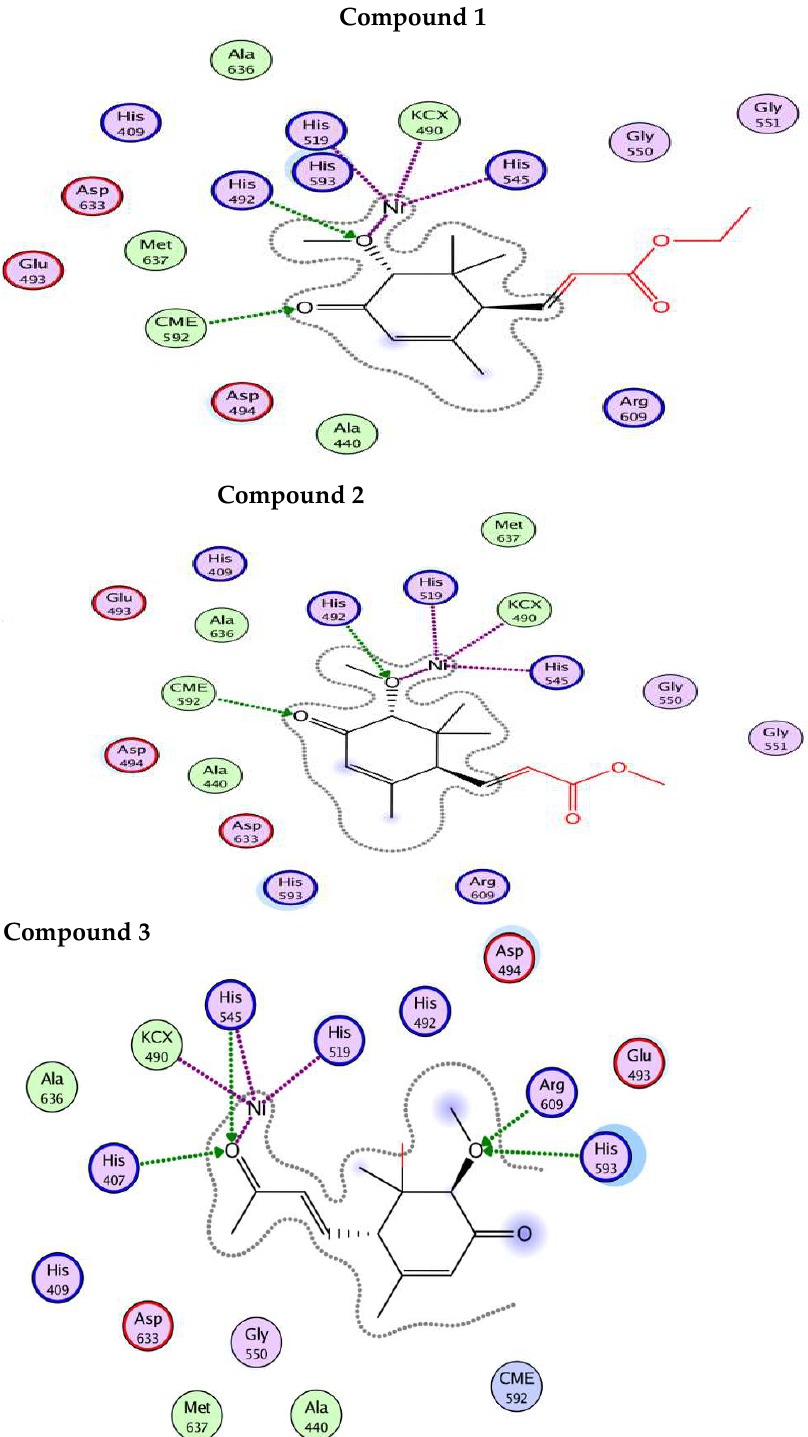
Figure 2. 2D interaction plot of compounds ( 1 – 3 ) with active site residues of urease using LigX tools of MOE software. The three-letter amino acid code is assigned to each residue.